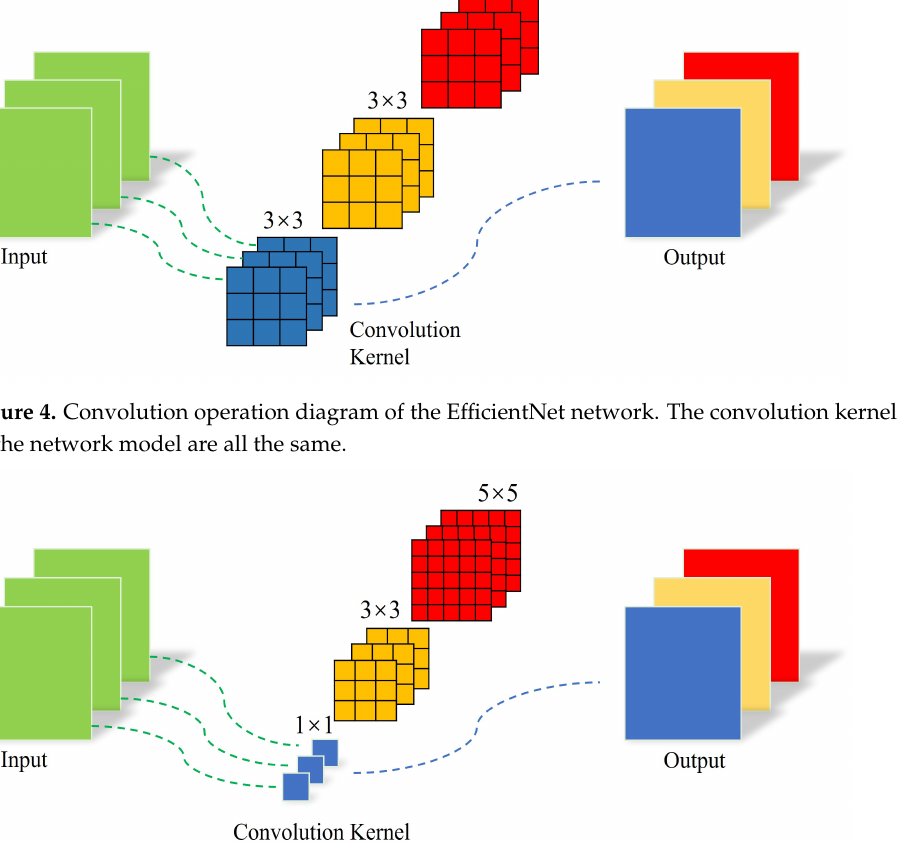
Figure 5. Convolution operation diagram of the PConv module in the EfferNet network. The proposed network model uses convolution kernels of different